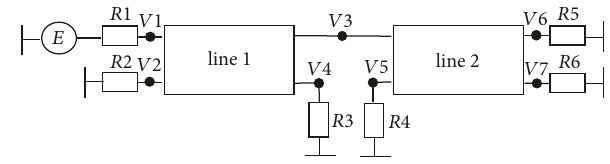
Figure 10: Schematic diagram of the structure under study with the break in the passive